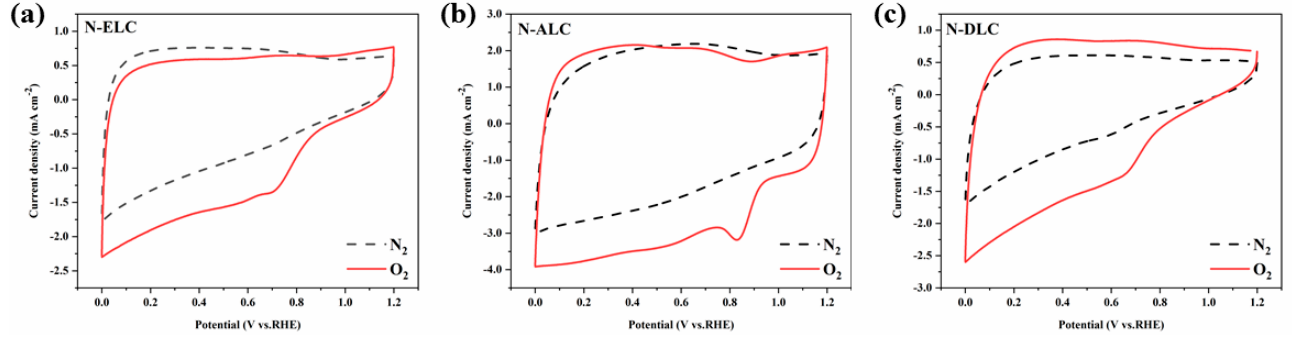
Figure 8. CV curves of different catalysts in O 2 − and N 2 − saturated electrolytes. ( a ) N − ELC; ( b ) N − ALC; ( c ) N − DLC.